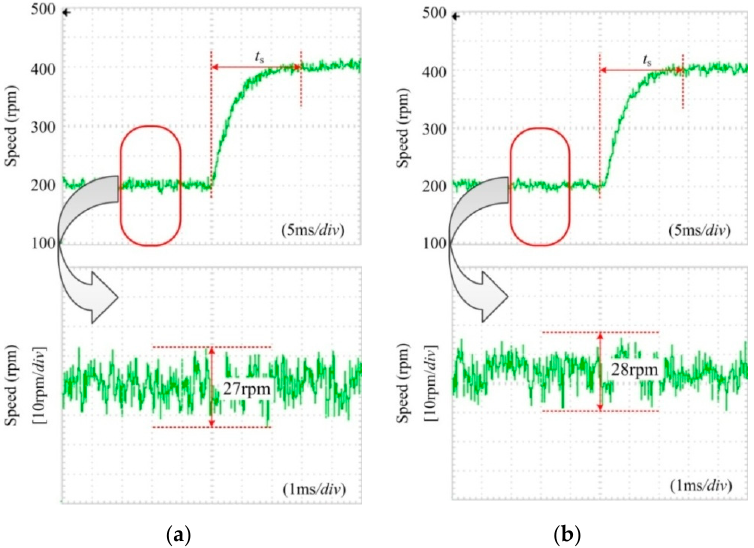
Figure 10. The speed trajectory from 200 rpm to 400 rpm when using: ( a ) FS-DTC; ( b ) FS-DDTC.